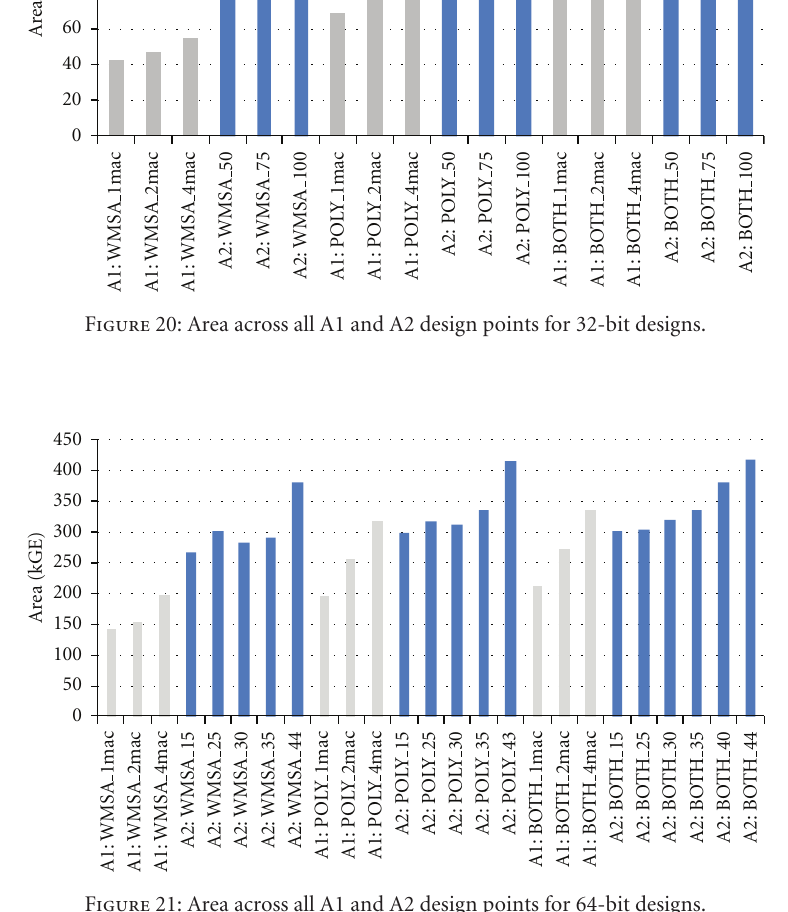
Figure 21: Area across all A1 and A2 design points for 64-bit